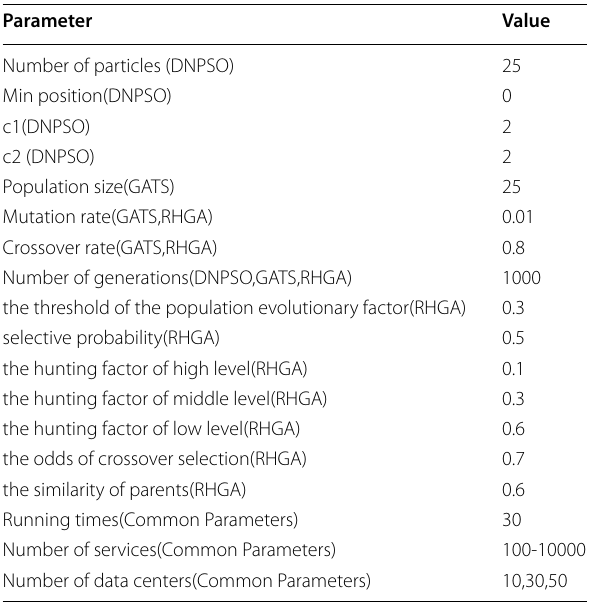
Table 2 The specific algorithm parameters